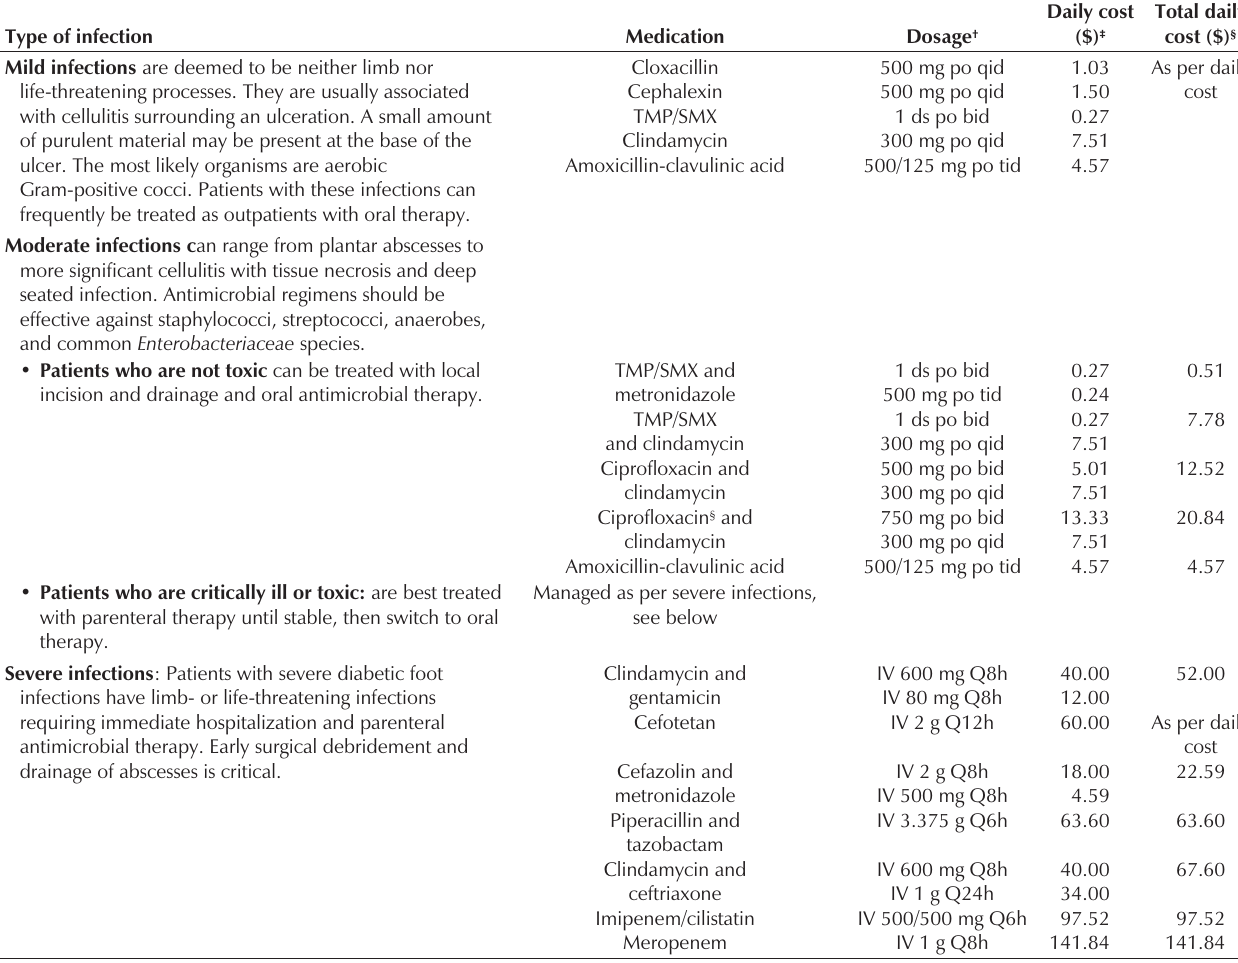
TABLE 1A Antibiotic therapy for infected ulcerations in the lower extremity of people with diabetes – Skin and soft tissue Type of infection Medication Dosage †